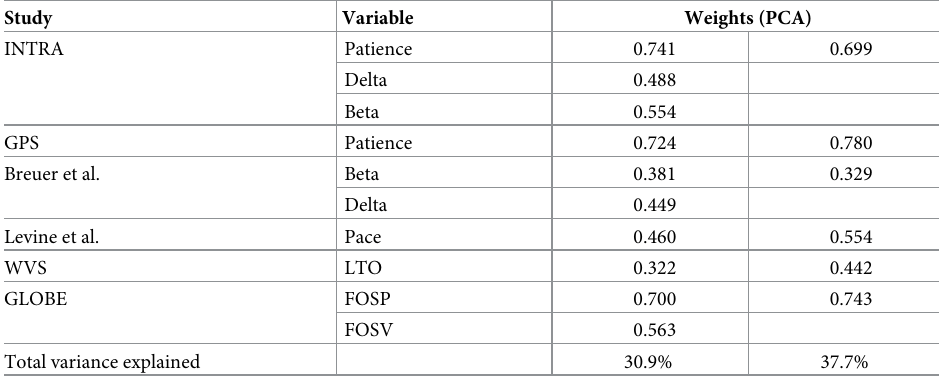
Table 3. Weights of the Principal Component Analysis